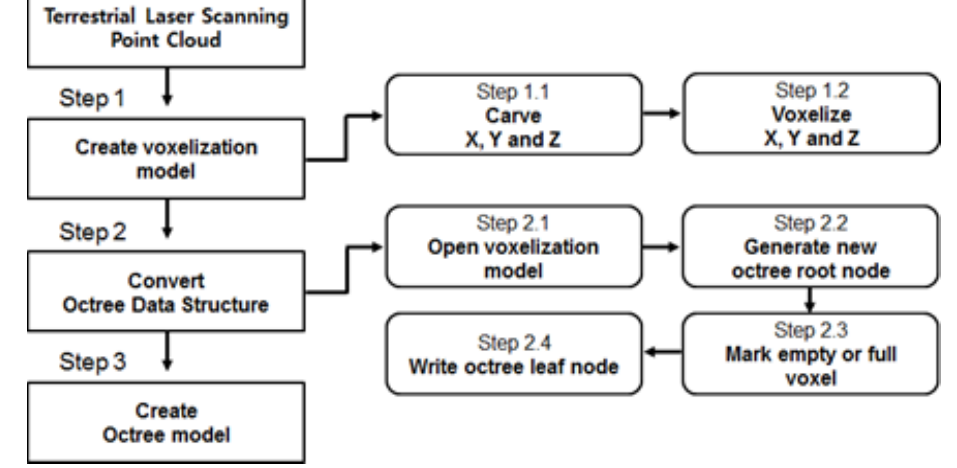
Figure 11. Process of building the octree information model.